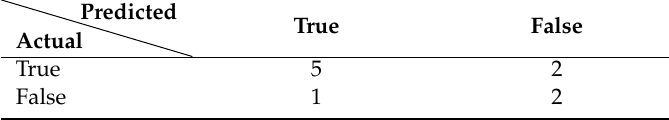
Table 6. Classification results using the confusion matrix.